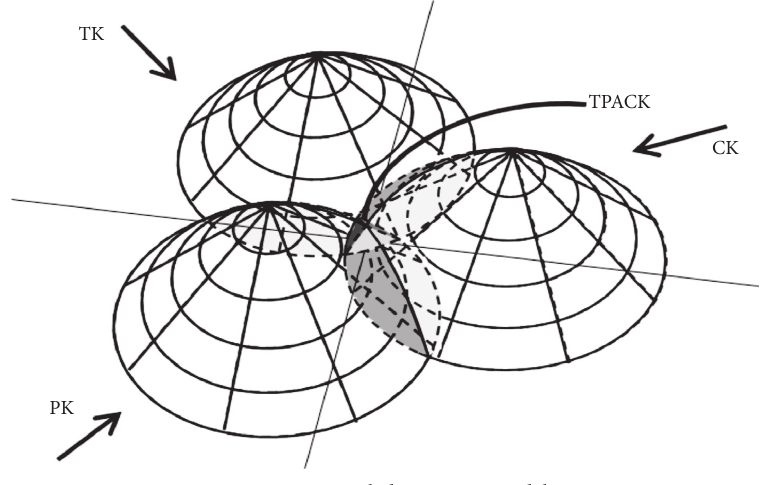
Figure 3: Knowledge system